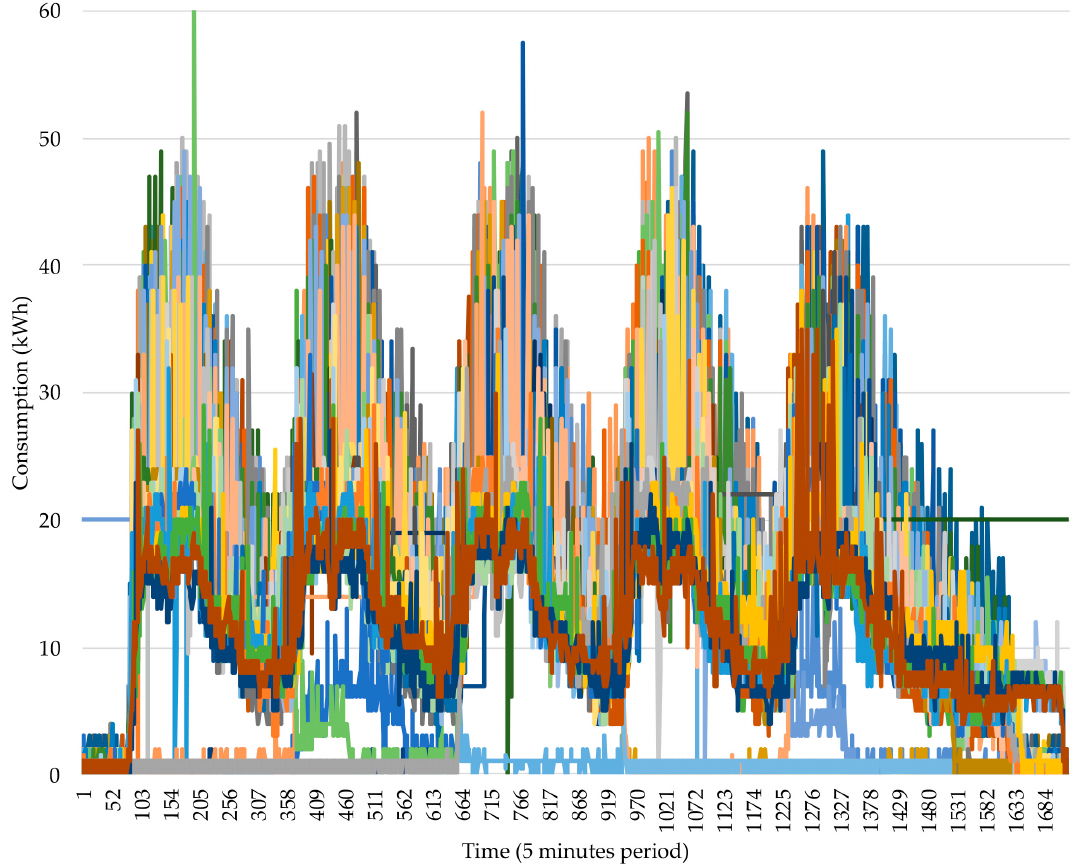
Figure 2. Weekly consumption from 1 January 2018 to 13 April 2019. Each line is one week (1728 points).